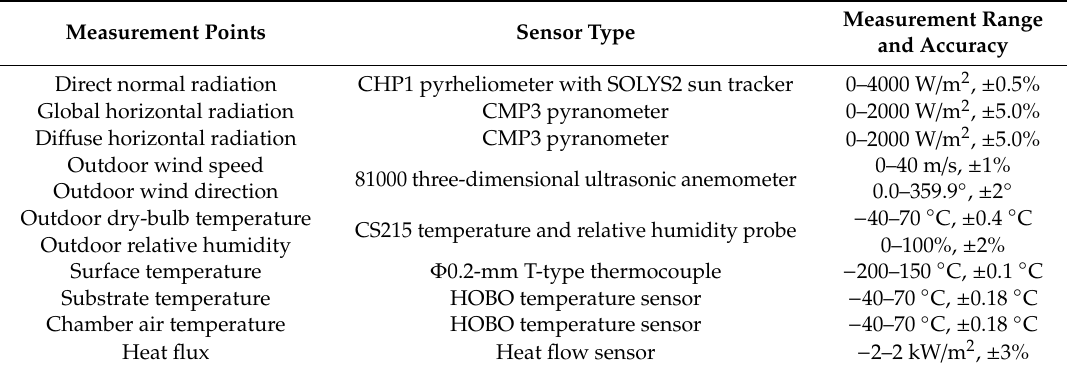
Table 1. Measurement devices and parameters.